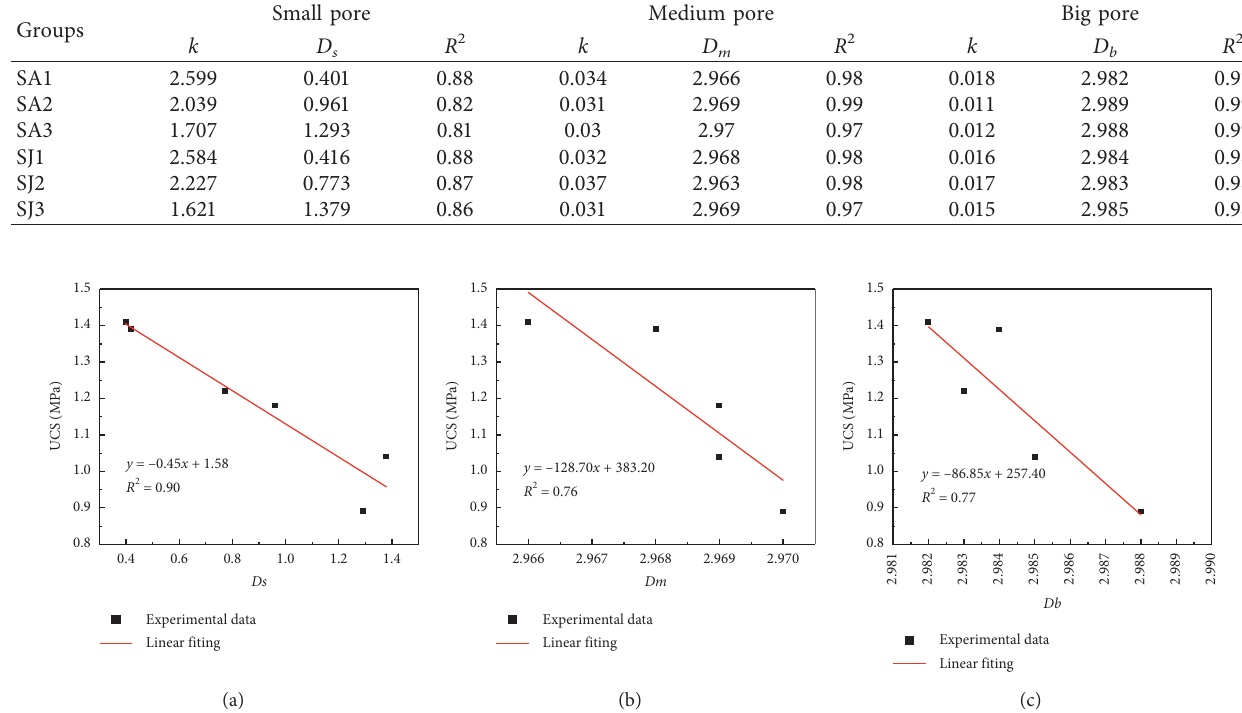
Table 6: Fractal dimension of various